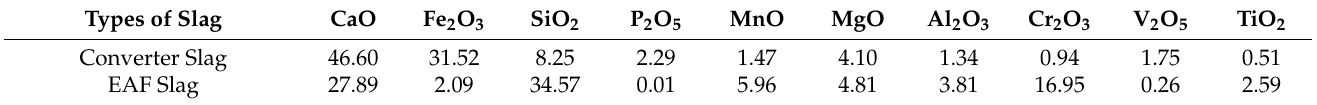
Table 2. Chemical compositions of converter slag and EAF slag used for this study, (wt%).